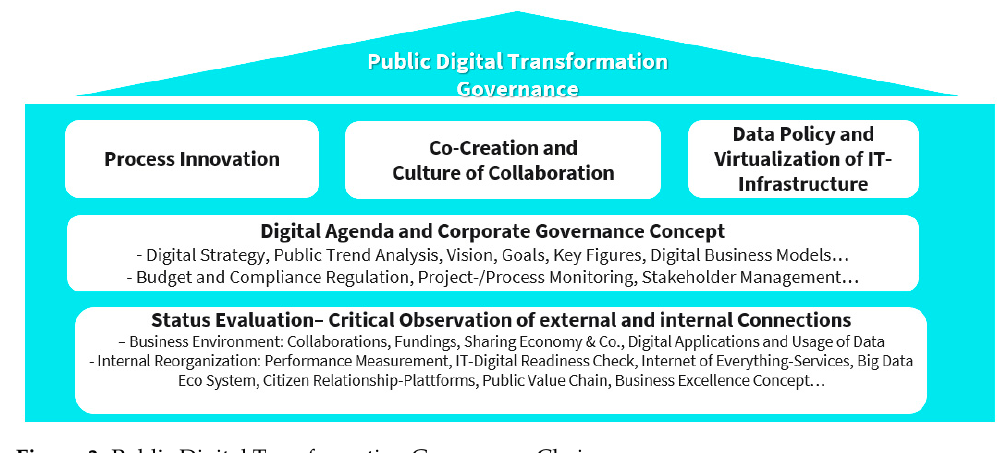
Figure 3. Public Digital Transformation Governance